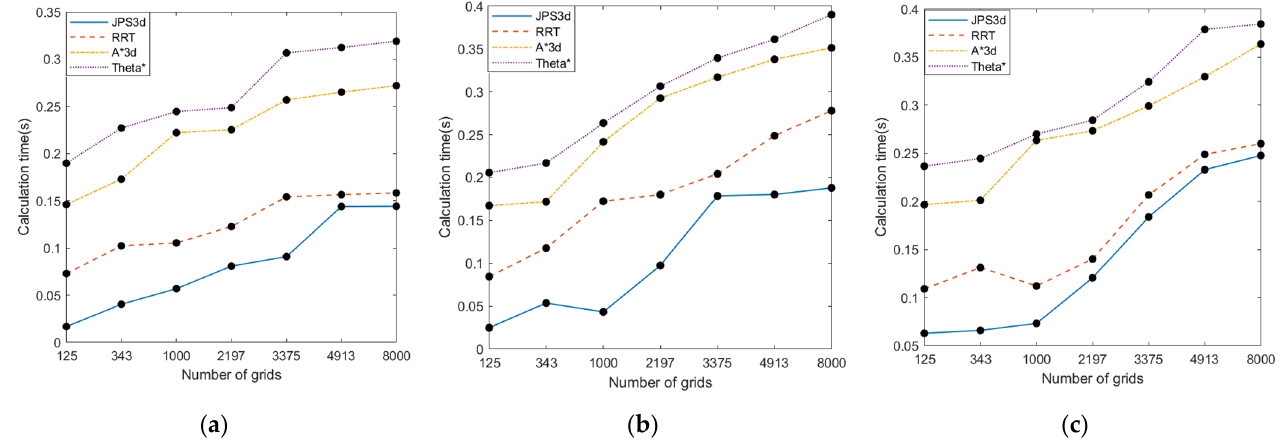
Figure 16. Experimental comparison of algorithms based on randomness maps. ( a ) Obstacles ac ‐ counted for 20%. ( b ) Obstacles accounted for 30%. ( c ) Obstacles accounted for 40%.